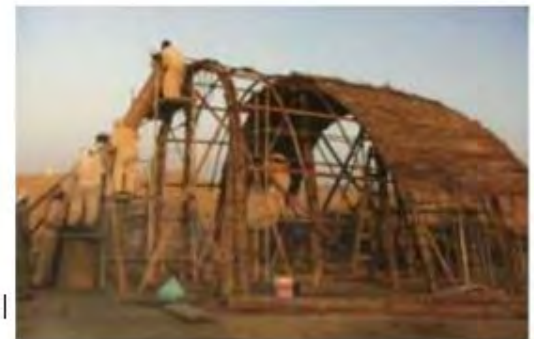
Figure 7. The Vault during Construction (Piesik, 2012)